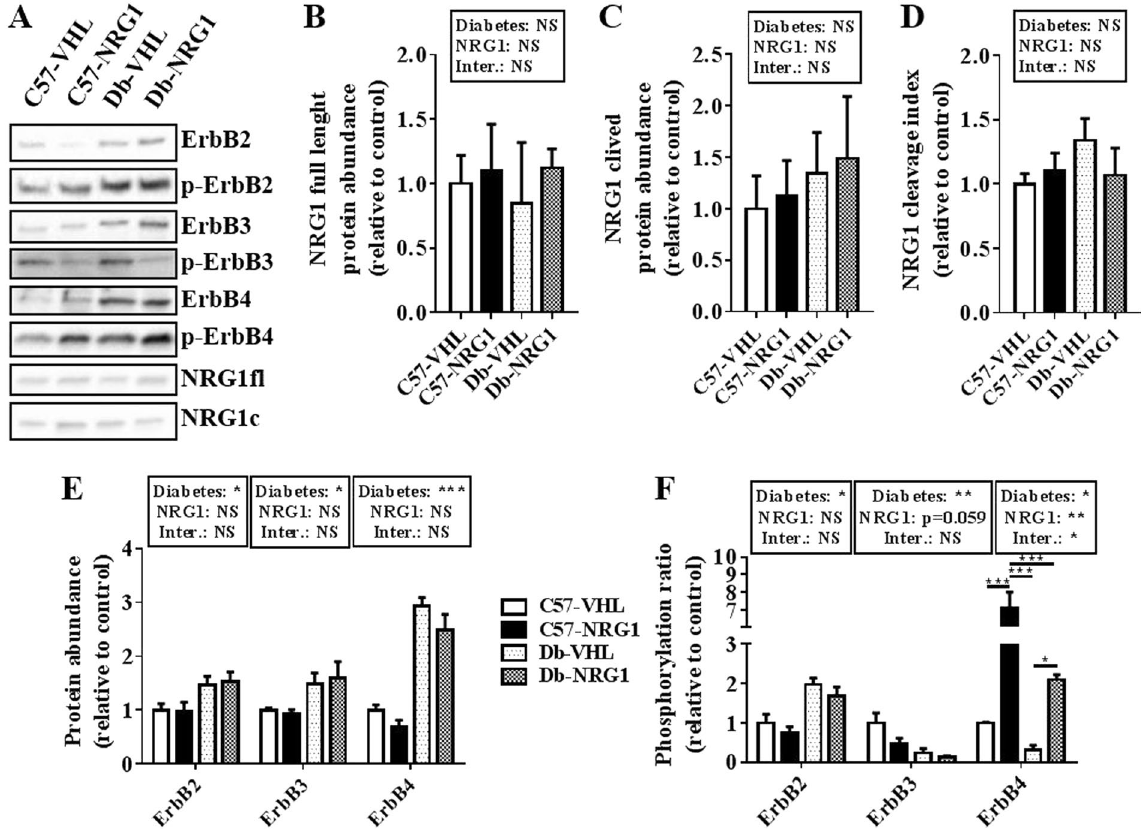
Figure 3. NRG1 treatment increases ERBB4 activation in gastrocnemius muscle. C57BL/6JRJ (C57) control and db/db (Db) male mice were treated with vehicle (VHL; 0.9% NaCl solution; n = 8/each condition), or with NRG1 (50 μ g . kg − 1 ; n = 8/each condition), three days per week for eight weeks. Western blot analysis ( A ) cropped images) was used to quantify in gastrocnemius muscle samples the abundance of full length (115 kDa) ( B ) and cleaved (42 kDa) ( C ) NRG1 and the NRG1 cleavage index (the ratio between cleaved and full length NRG1) ( D ) as well as the abundance ( E ) and phosphorylation ratios ( F ) of ERBB2, ERBB3 and ERBB4. Results are the mean ± SEM (n = 8 per group) relative to the level in untreated healthy mice (C57-VHL, white bars). Diabetes (healthy vs db/db mice) and NRG1 (saline vs NRG1) effects were investigated with a 2 × 2 ANOVA. When a significant interaction was found, the Tuckey’s test was used for post-hoc multiple comparisons. * p < 0.05, ** p < 0.01, *** p < 0.001, NS: not